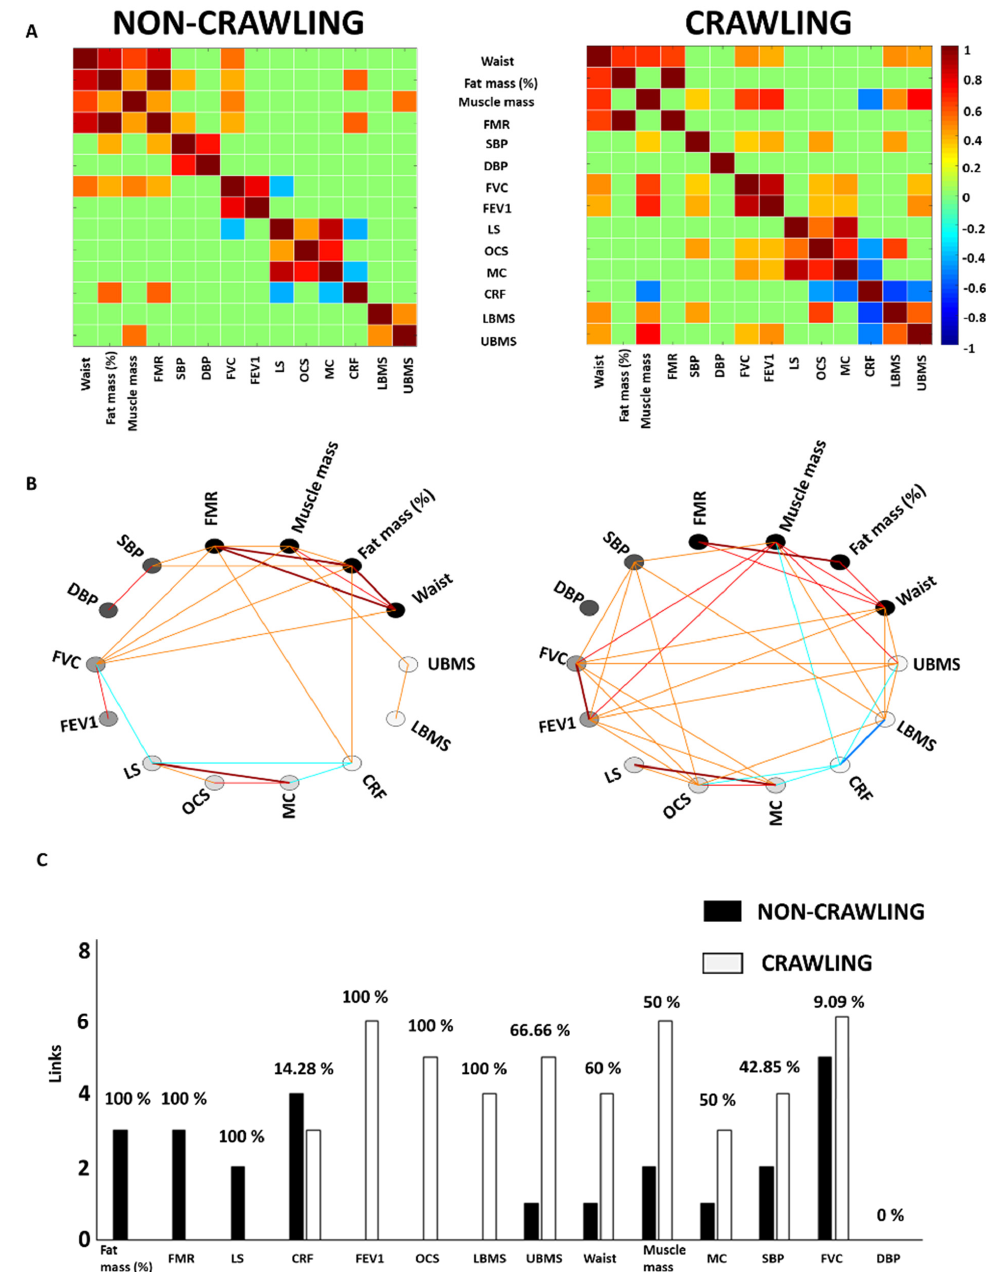
Figure 1. Network interactions change between body systems depending on whether children crawled or not before walking. ( A ) Body systems matrix. The matrices show the Pearson correlation coefficient between body systems. Non-significant correlations are represented in green. ( B ) Body systems networks. Each node represents a specific body system for each category (body composition (dark black), cardiovascular system (dark gray), lung function (gray), motor competence (light grey) and physical fitness (bone white)). Links between two nodes represent the coupling strength (i.e., the Pearson coefficient) between two genes. The links are divided into six types: strong positive links (SPL; Pearson coefficients > 0.8), intermediate positive links (IPL; 0.6 < Pearson coefficients < 0.8), weak positive links (WPL; 0.32 < Pearson coefficients < 0.6), weak negative links (WNL; − 0.32 > Pearson coefficients > − 0.6), in- termediate negative links (INL; − 0.6 > Pearson coefficients > − 0.8), and strong negative links (SNL; Pearson coefficients < − 0.8). ( C ) Total number of linked interactions for each variable. The height of the bar corresponds to the number of significant correlations in the body systems